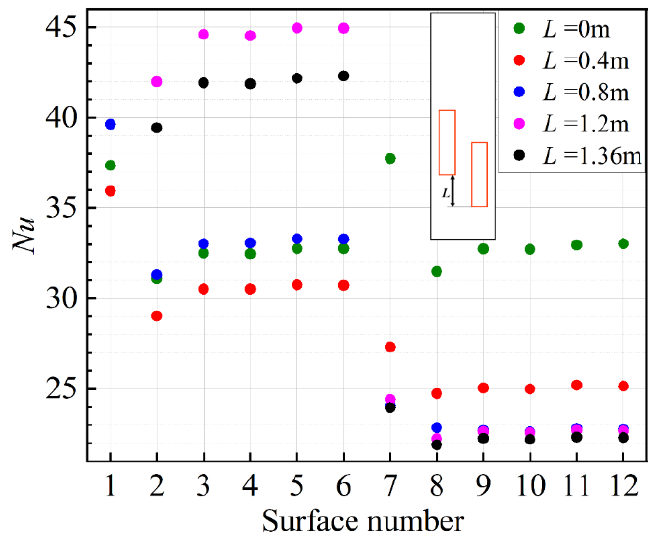
Figure 11. The distributions of average Nusselt number of all the surfaces of the heat sources with different L .